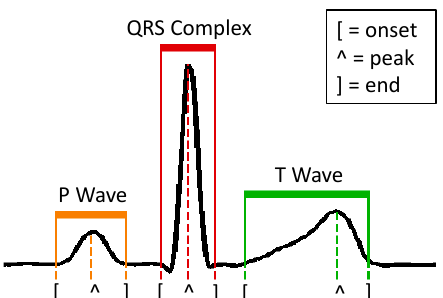
Figure 3. Delineated normal heartbeat